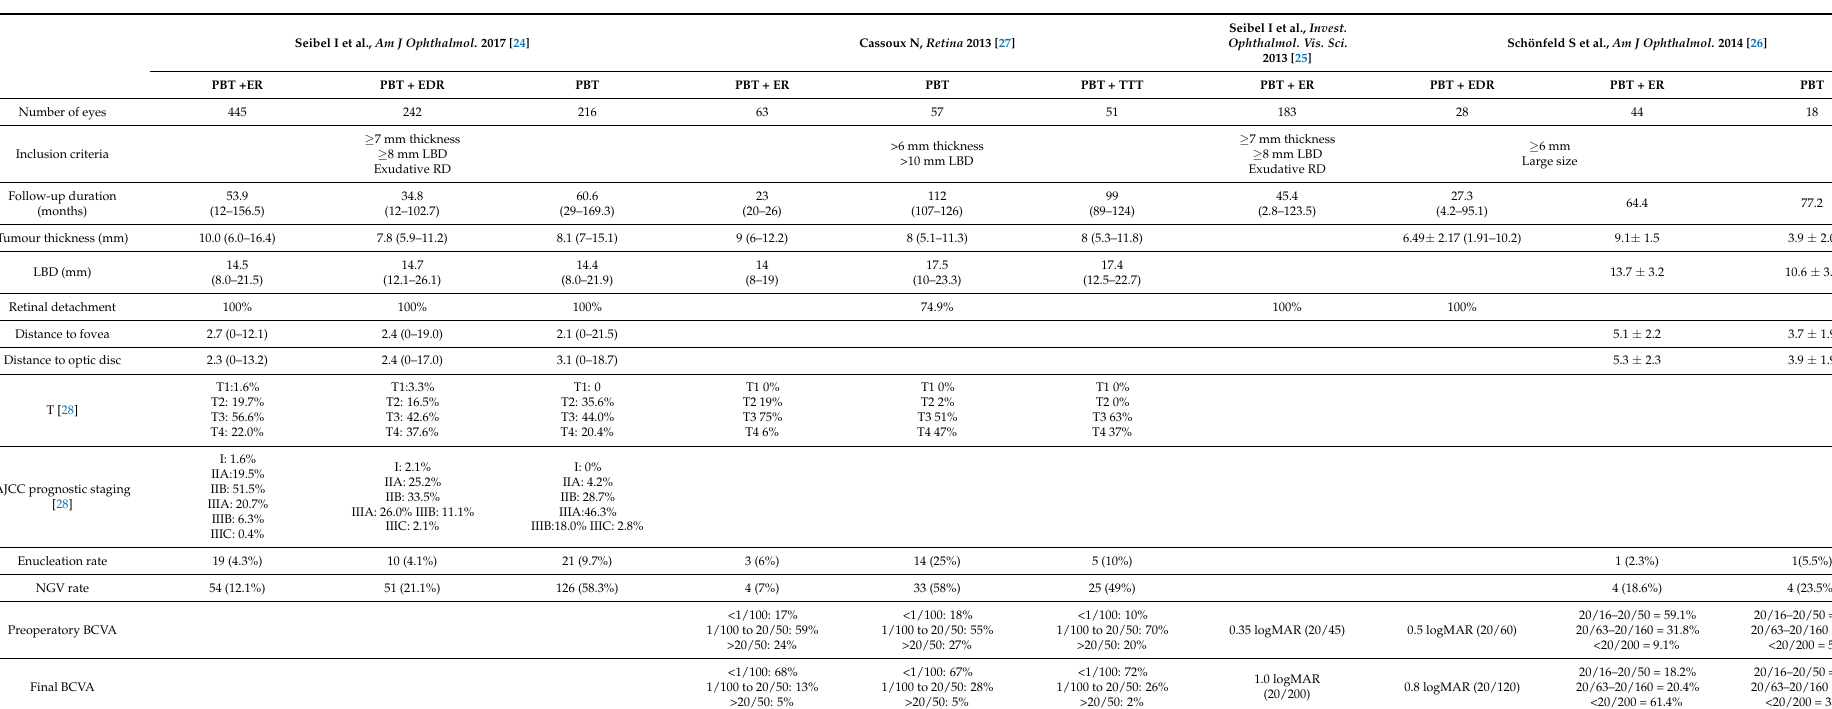
Table 3. Summary of selection criteria and outcome data from comparative studies on endoresection and endodrainage applied for the prevention of toxic tumour syndrome after proton beam treatment. EDR = endodrainage; ER = endoresection; PBT = proton beam; RD = retinal detachment; LBD = largest basal diameter; TTT = transpupillary thermotherapy; BCVA = best corrected visual